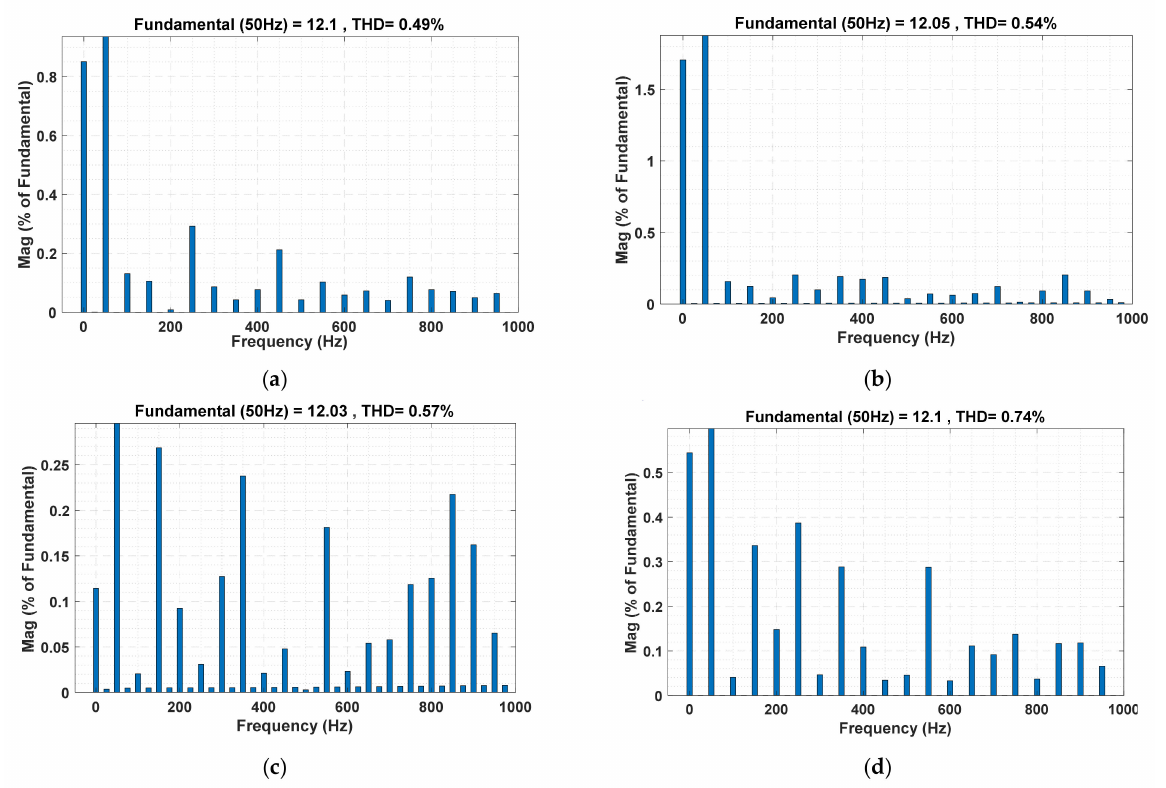
Figure 21. Harmonic spectra for ( a ) PSO-CHCC, ( b ) FBI-CHCC, ( c ) AOA-CHCC, and ( d ) IAOA- CHCC.